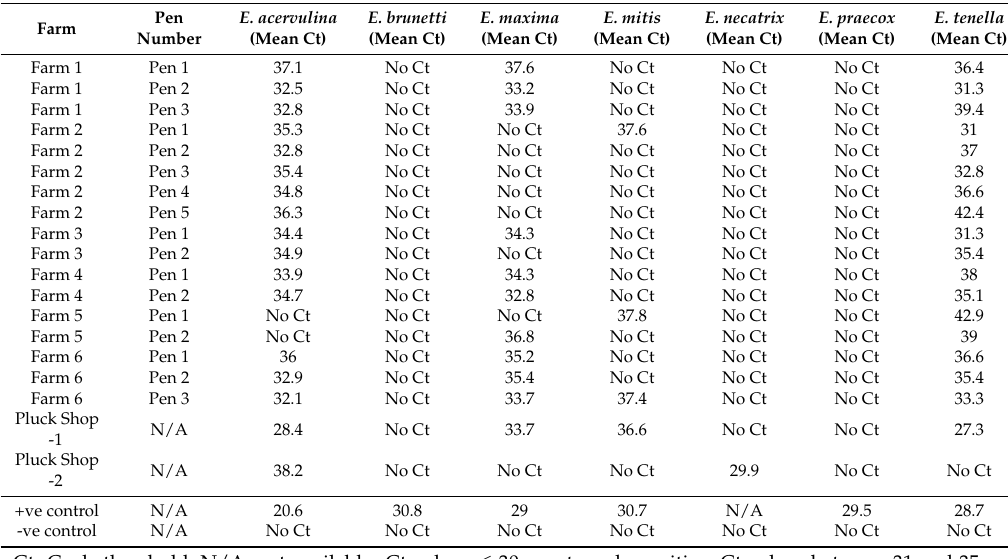
Table 1. Real-time polymerase chain reaction (qPCR) results for the seven (7) Eimeria species of poultry in pooled fecal samples taken from multiple pens on six broiler farms and two pluck shops in Trinidad, West Indies.